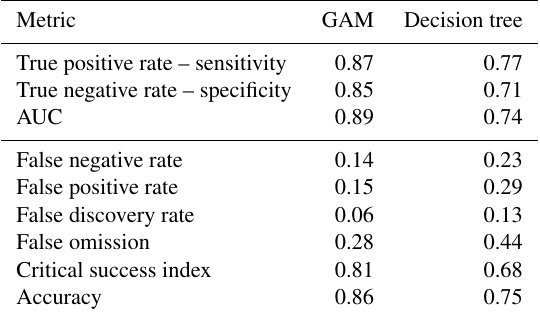
Table 3. Generalized additive model (cutoff 0.66) and decision tree model performance metrics ( n = 140 in both models). Sensitivity, specificity, and AUC (area under receiver operating characteristic curve) were calculated using a leave-one-out cross validation. Miss rate through to accuracy statistics were calculated using all data to train the model tested against